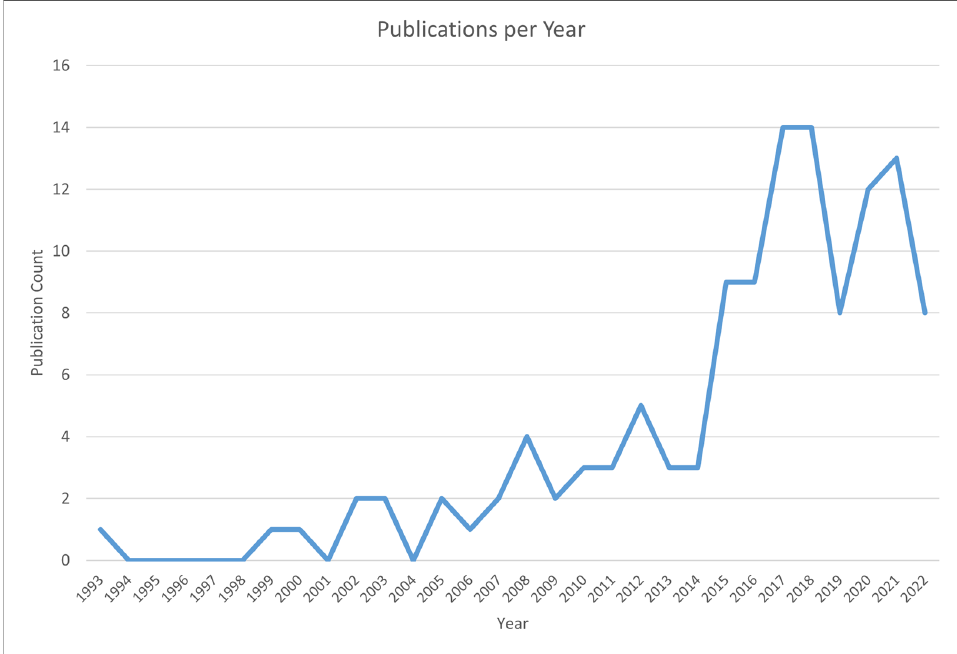
Figure 16. Number of related publications reviewed in this work (122 selection), per year since 1993.